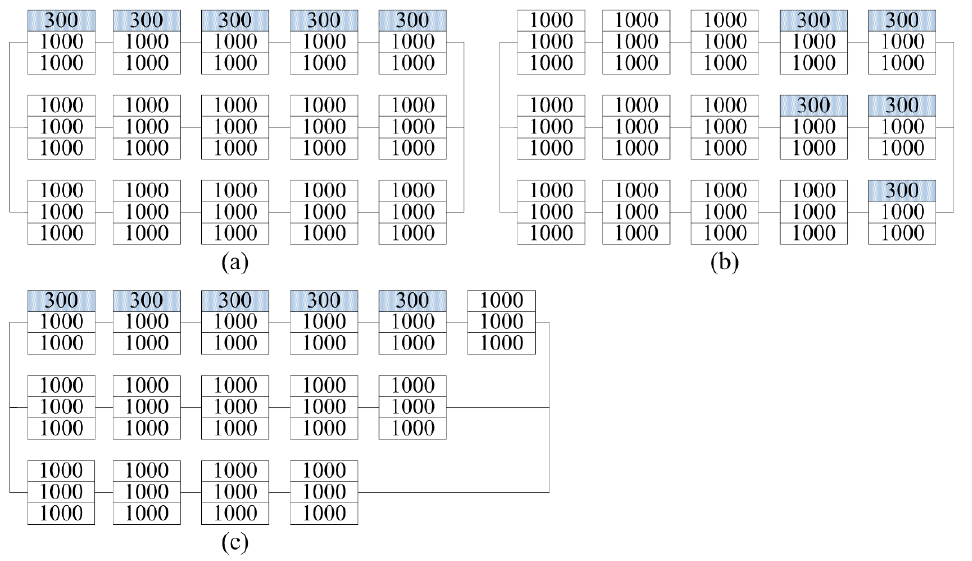
Figure 16. P-V curve of a PV array before and after reconfiguration.